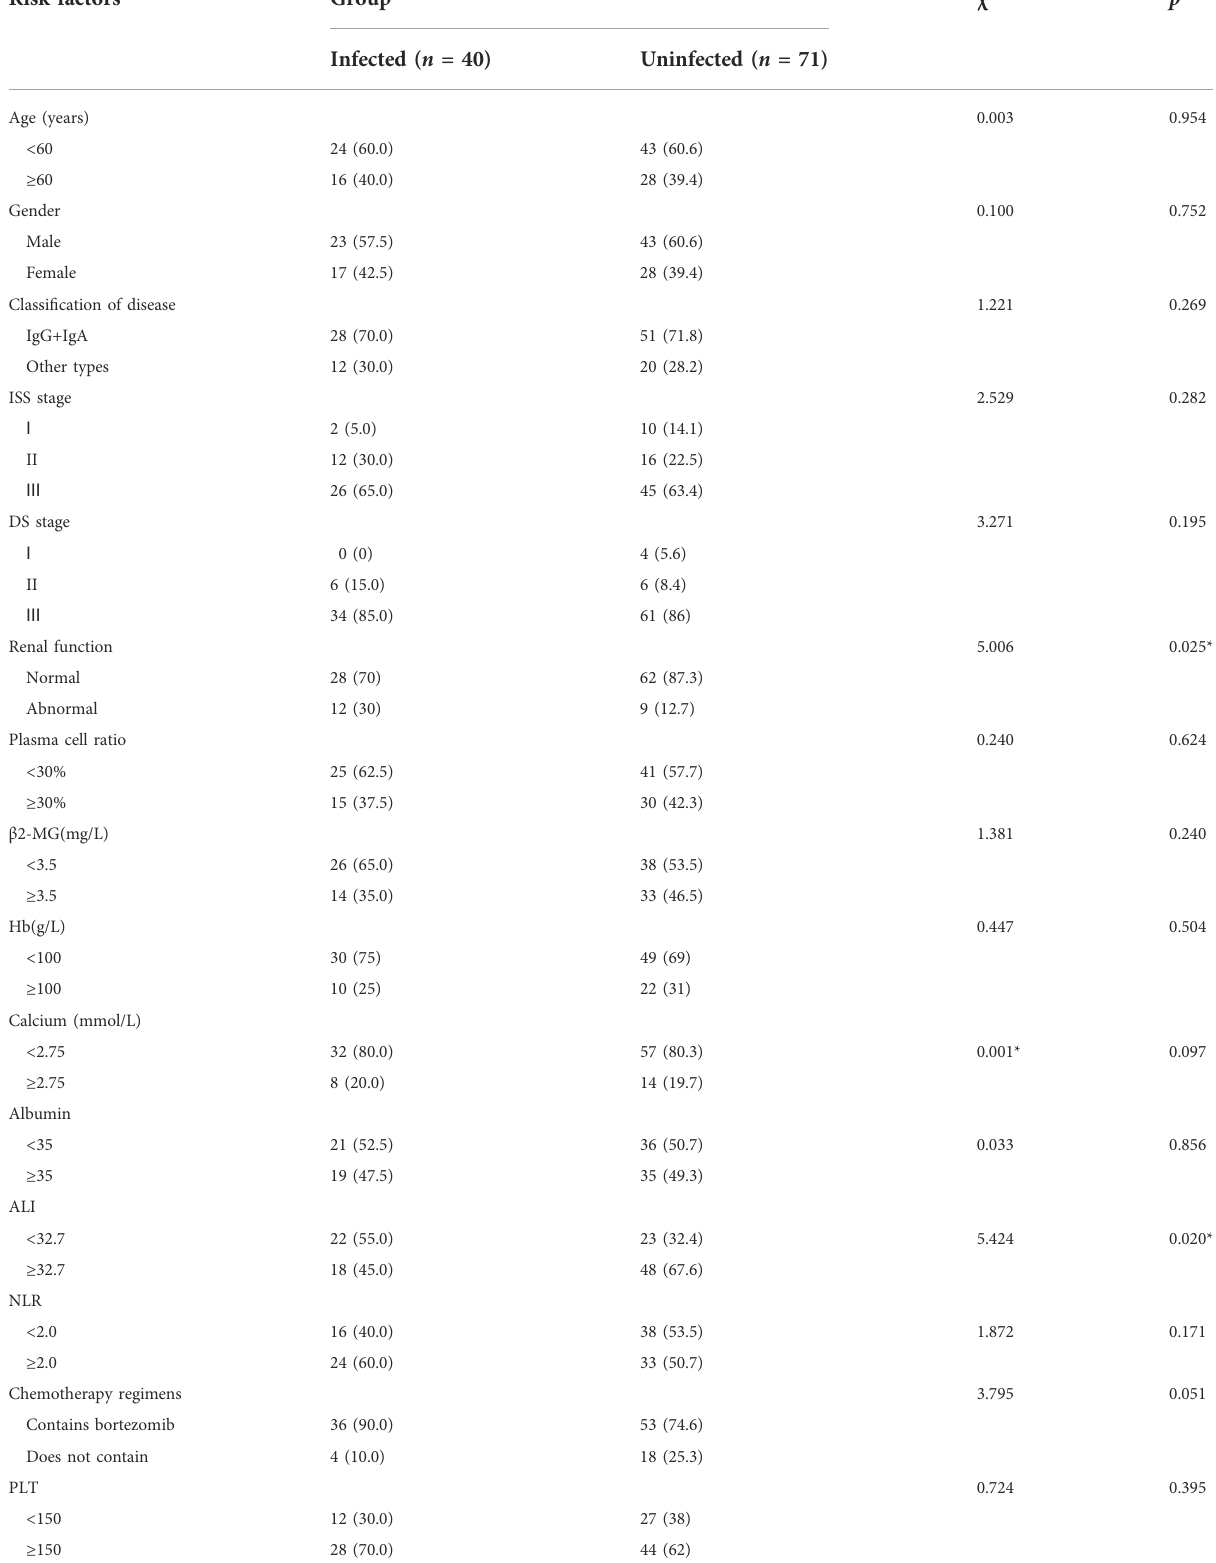
TABLE 4 Univariate analysis of infection after chemotherapy in patients with